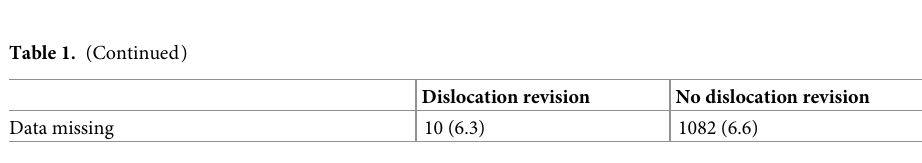
BMI = Body Mass Index, ASA score = American Society of Anesthesiologists score. � BMI coverage in the data: 96%.